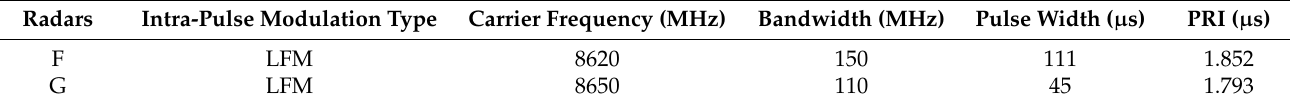
Table 4. Parameter settings of Radar F and Radar G.